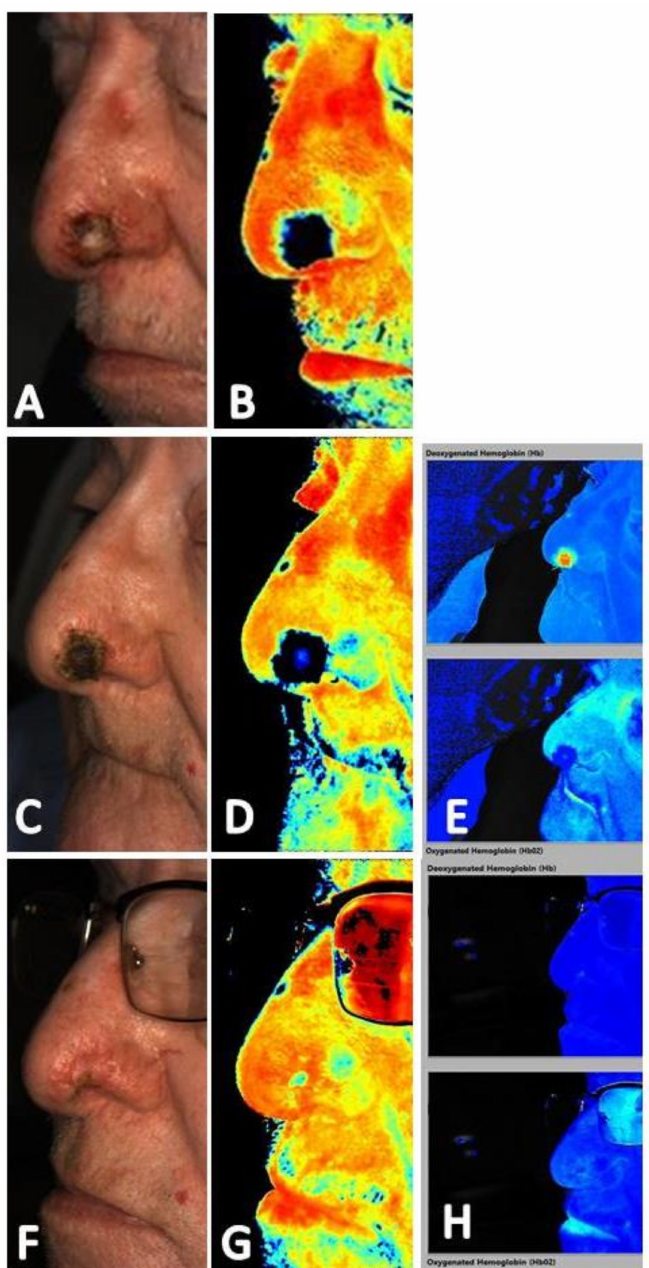
Figure 9. ( A ) Baseline clinical photograph; and ( B ) near-infrared image assessment of patient that had undergoing a Mohs procedure on the nose (23 July 2020). These images were taken one week prior to initiation of hyperbaric oxygen therapy. Note the absence of signal within the location of the wound on the near-infrared image ( B ). ( C ) Clinical photograph and ( D ) near-infrared image assessment following 11 sessions of hyperbaric oxygen therapy (21 August 2020). Note increase in signal seen in the center of the wound. ( E ) The corresponding deoxygenated hemoglobin (top) and oxygenated hemoglobin (bottom) views showing increased in deoxygenated hemoglobin consistent with angiogenesis occurring from the venous side within the wound. ( F ) Clinical photograph and ( G ) near-infrared image assessment following wound resolution (10 September 2020) and 19 sessions of hyperbaric oxygen therapy. ( H ) The corresponding deoxygenated hemoglobin (top) and oxygenated hemoglobin (bottom) views show an increase of oxygenated hemoglobin to the